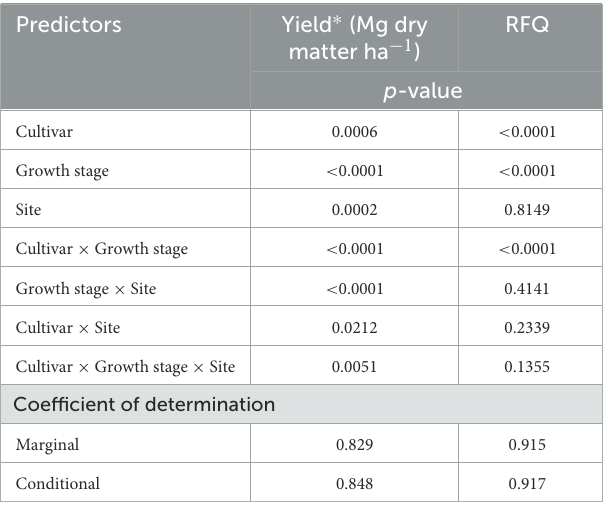
TABLE 2 Analysis of variance for yield (Mg dry matter ha − 1 ) and relative forage quality (RFQ) as affected by winter cereal cultivar (all twelve), growth stage (Zadoks), and site (MD and